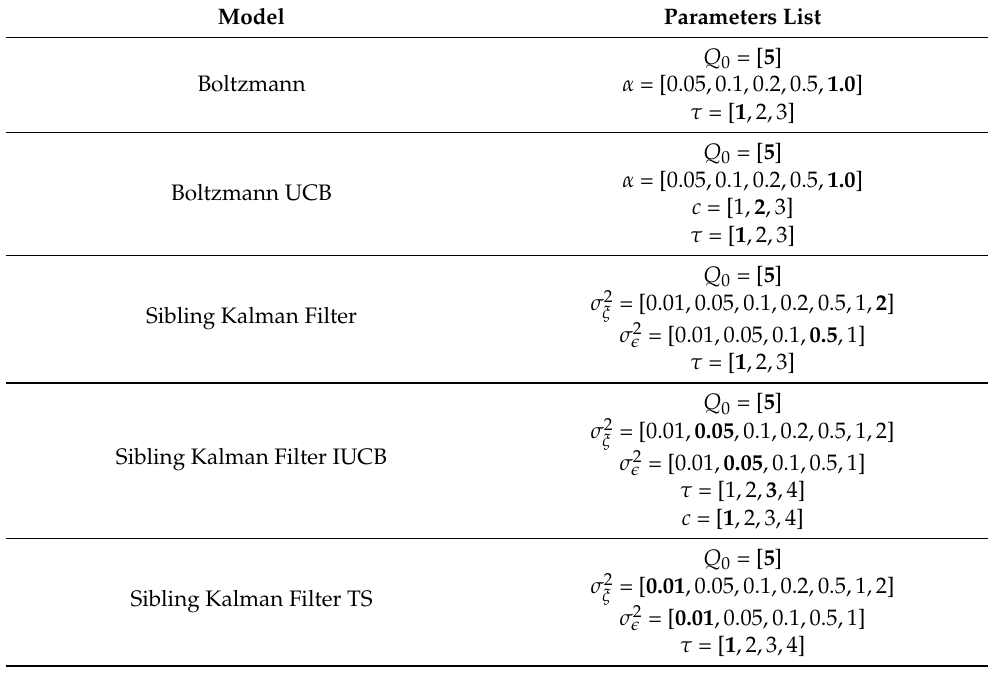
Table 4. List of hyperparameters. The selected hyperparameters are in bold.